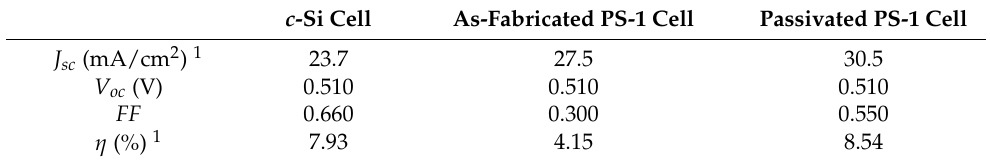
Table 2. PV parameters for PS-1 cell, as-fabricated passivated PS-1 cell, and reference c -Si cell.